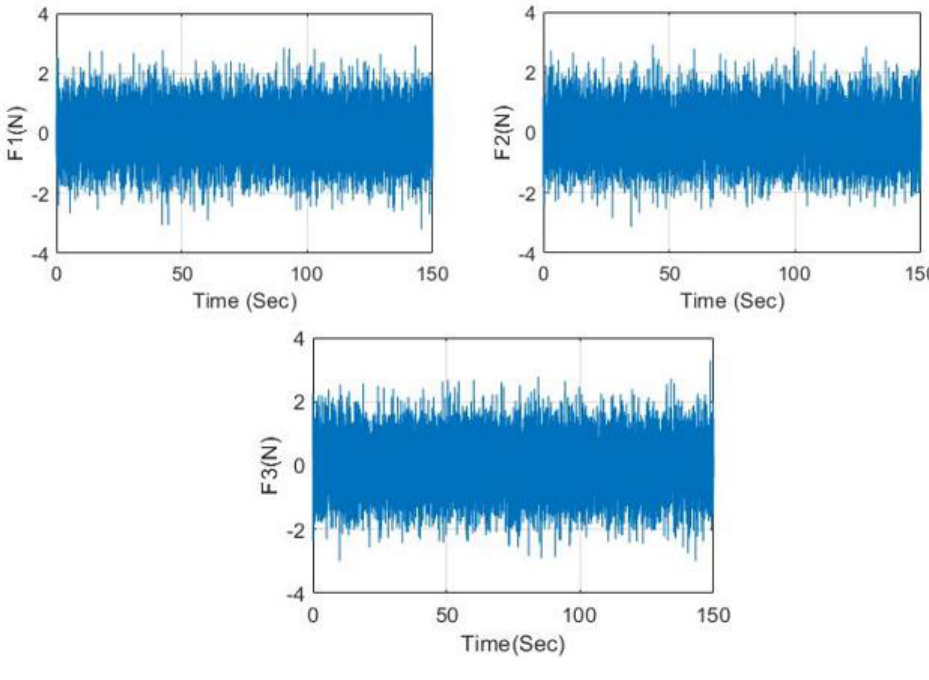
Figure 1. Random forces exerted on the structure.